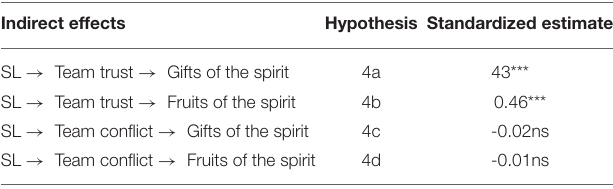
TABLE 2 | Results of structural equation modeling of standardized indirect effects with non-significant effects. Indirect